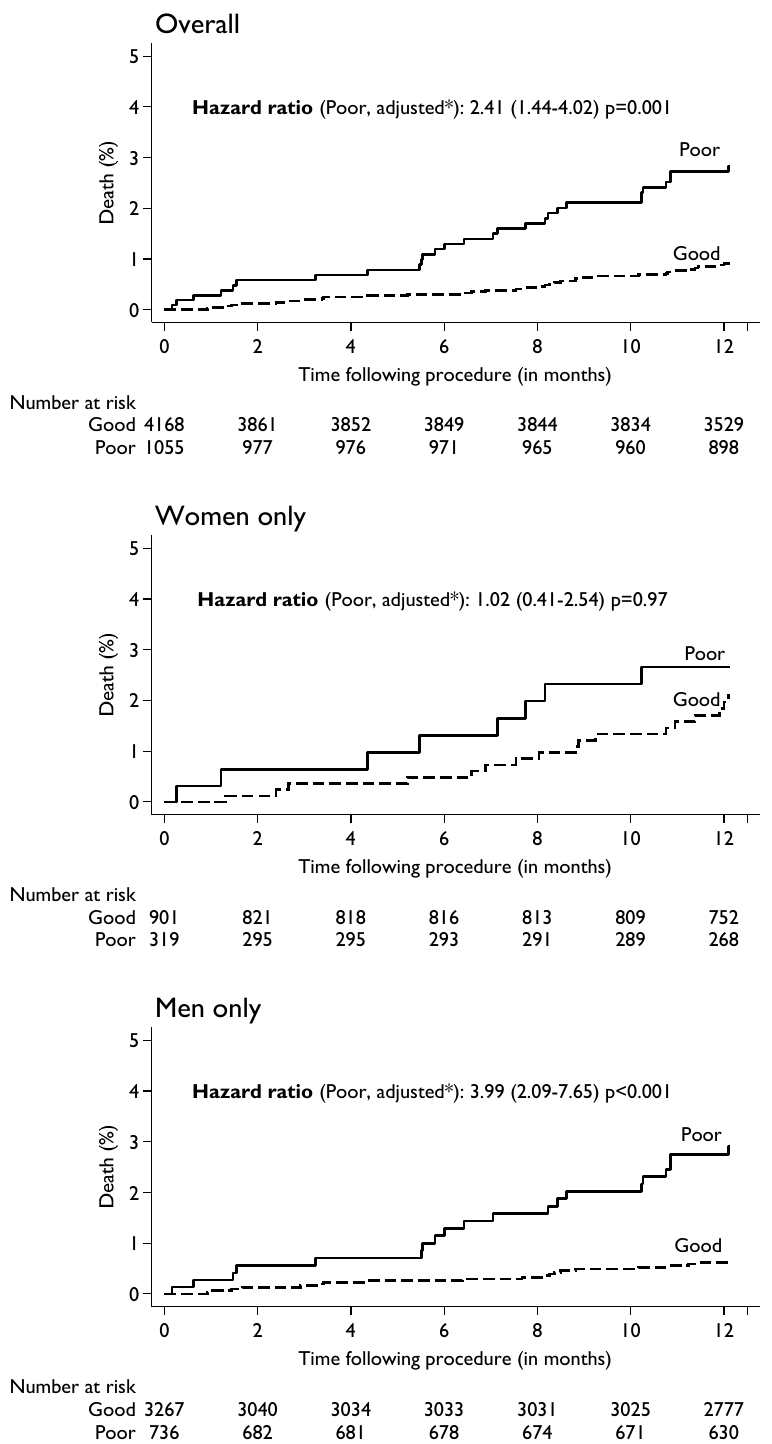
Figure 1. Pre-procedure HRQoL (N = 5223) and its association with mortality within one-year following procedure in the Overall (top), women only (middle) and men only (bottom panel). * Adjusted for age, sex (except for gender specific analysis), BMI, smoking, PCI presentation, diabetes, LVEF, previous MI, PVD, previous CABG, HF within prior 2 weeks of PCI, renal failure and cardiogenic shock.